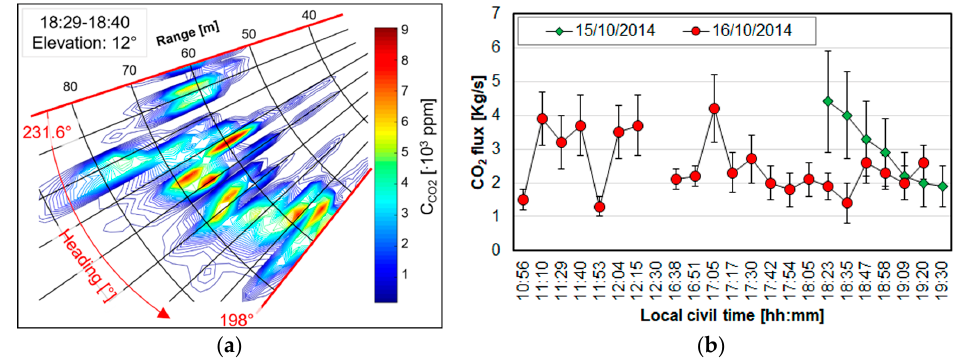
Figure 3. ( a ) An example of a lidar scan in polar coordinates through the plume at an elevation of 12° (15 October 15 2014). The contour lines show isopleths of background-corrected CO 2 mixing ratios in the plume (expressed in ppm, the legend is the vertical colored bar), shown as a function of heading and range. ( b ) Time-series of lidar-derived CO 2 fluxes from Pisciarelli obtained from 15 October (afternoon) to 16 October (afternoon), rearranged from Figure 4 reported in [21]. The timescale for the morning scans on 15 October is shown in green. Each point refers to a particular scan through the plume (time is the onset time of the scan, with each scan lasting 10–20 min) [21].